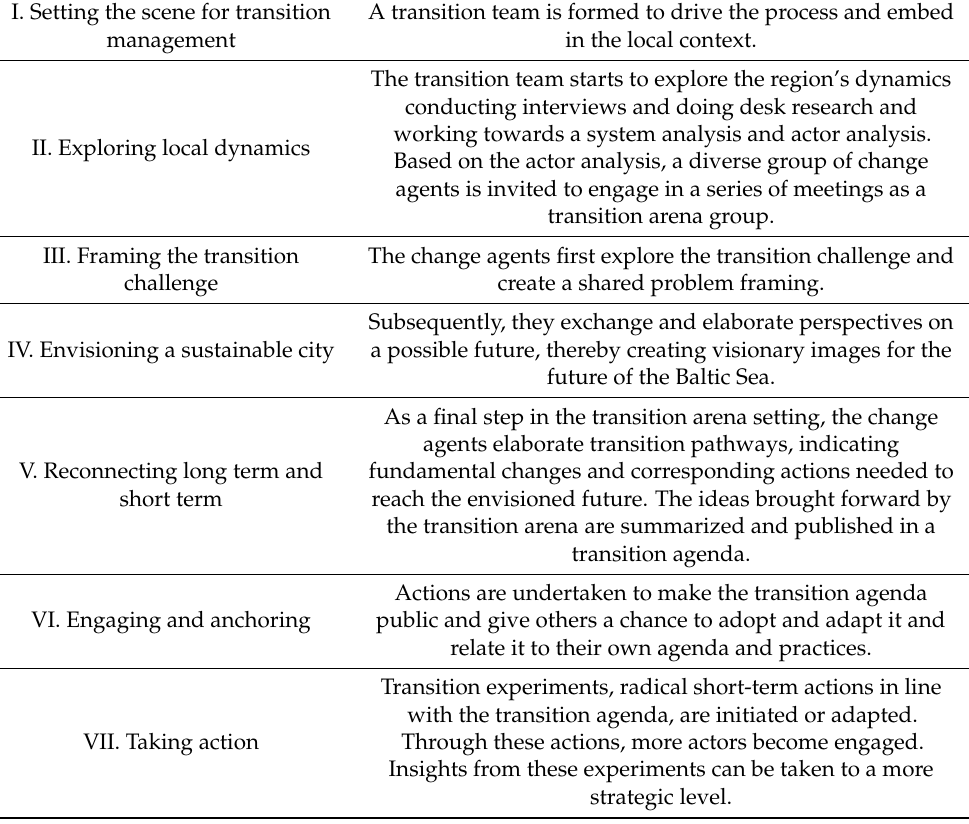
Table 1. The transition management stages (after